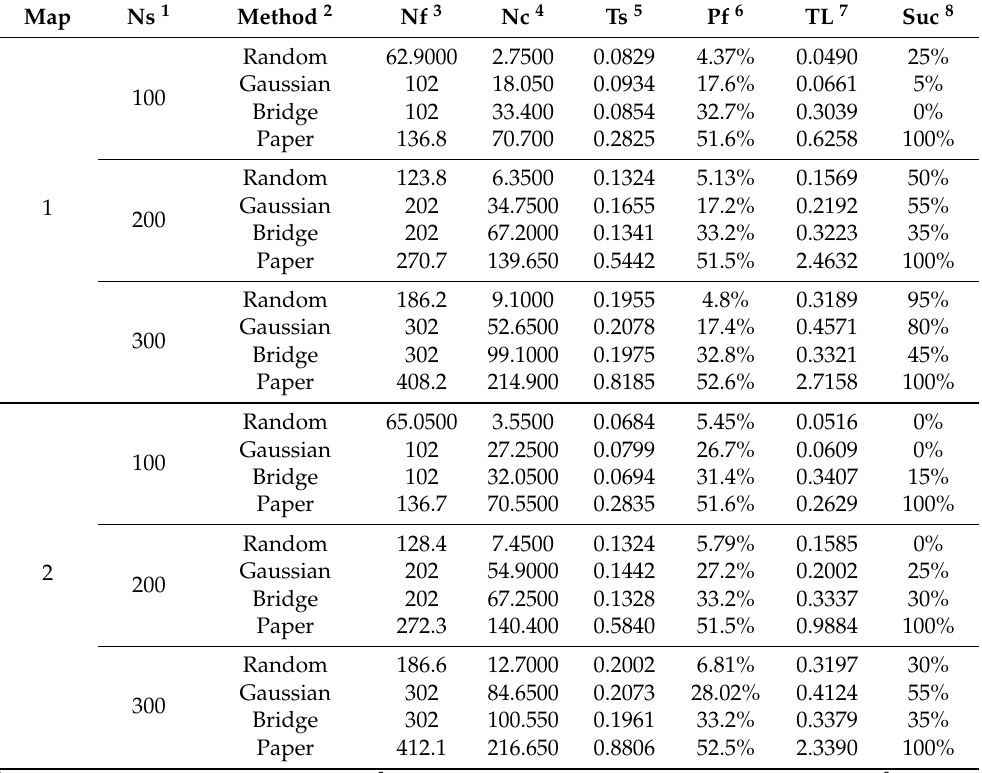
Table 1. Various parameters of four PRM algorithms in the single-channel environments.